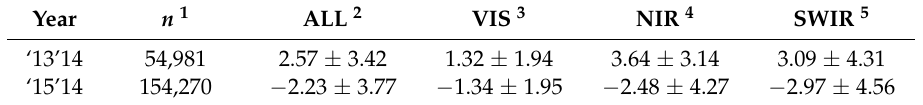
Table 3. Difference (%) in mean reflectance before calibration.